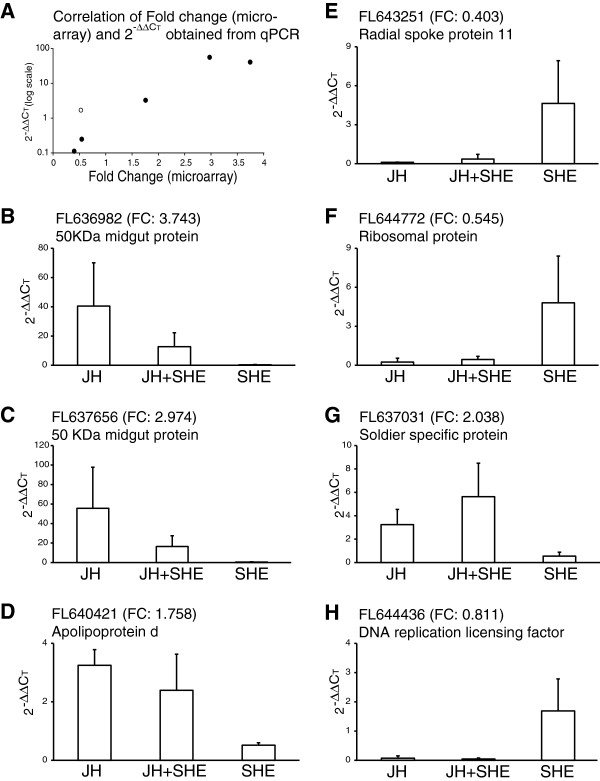
qPCR reassessment for seven ESTs after treatments with JH,
JH + SHE and SHE from the follow-up bioassay. A)
Shows a positive correlation of qPCR results from follow-up bioassays
against microarray fold change results for the six JH influenced ESTs
(Spearman rank correlation, Rs = 0.89,
df = 5, P = 0.02). The empty circle represents
an EST that was downregulated by both JH and SHE. B-H) Show
expression profiles for three JH upregulated ESTs (B, C
and D), two JH downregulated ESTs (E, F and
H), one SHE downregulated EST (G) and one SHE
upregulated EST (H). The expression level is presented as
2-ΔΔCT, calculated from qPCR cycle
threshold value. The microarray fold change values are provided in the
parentheses for each EST. FL644436 (G) was downregulated by both
JH (fold change: 0.543) and SHE (fold change: 0.811).